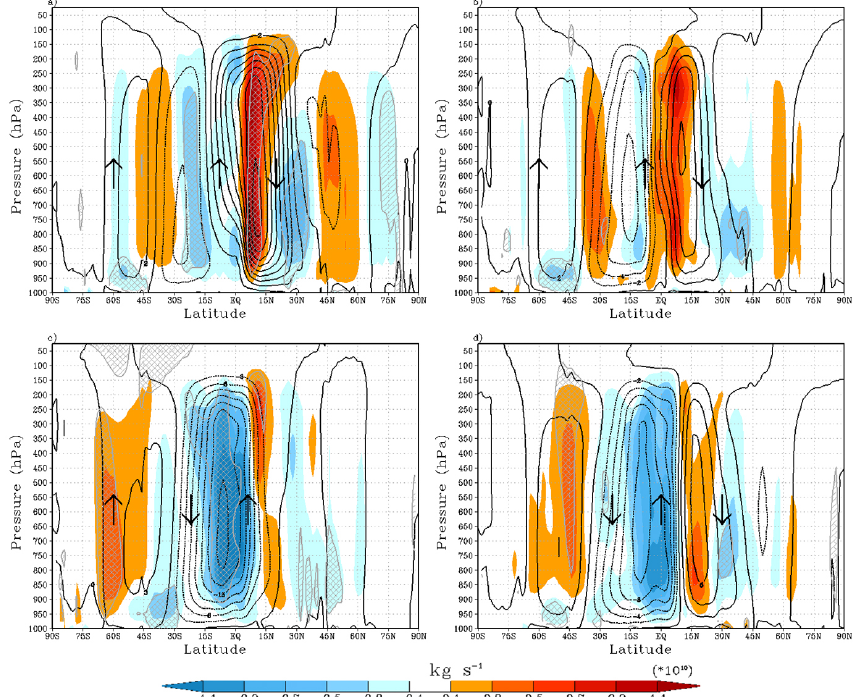
Figure 4. Seasonal mean difference (Method 3 minus Method 2; shaded) and average (contours) mean meridional circulation for (a) DJF, (b) MAM, (c) JJA, and (d) SON. Positive (negative) values are represented by solid (dashed) lines. Arrows indicate the sense of the circu- lation. Hatch marks represent significance at the 90% level using the Student’s t test. Crosshatch marks represent significance at the 95%